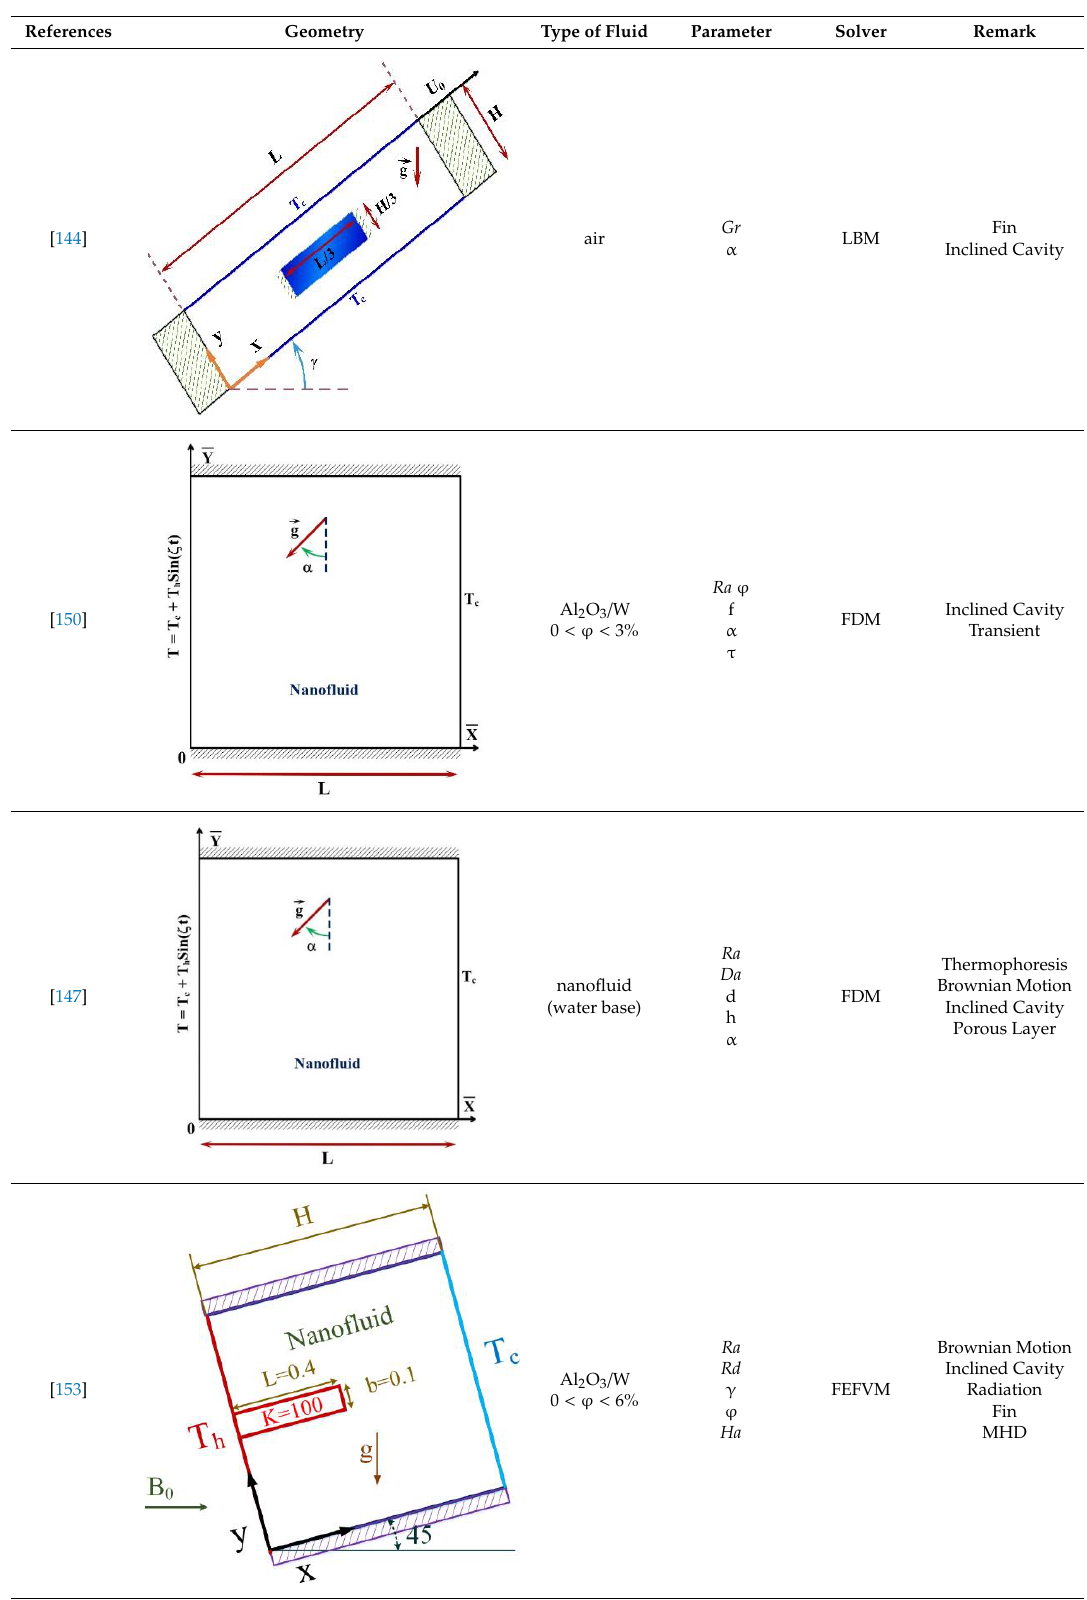
Table 8. Summary of some articles studied enclosures with di ff erent inclination angles.